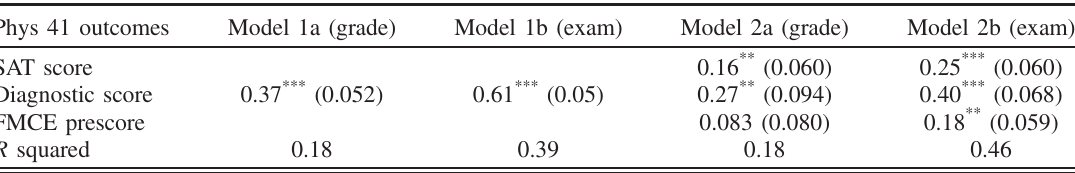
TABLE III. Regression of Phys 41 course and exam grades on measures of incoming preparation. ** p < 0 . 01 , *** p < 0 . 001 .